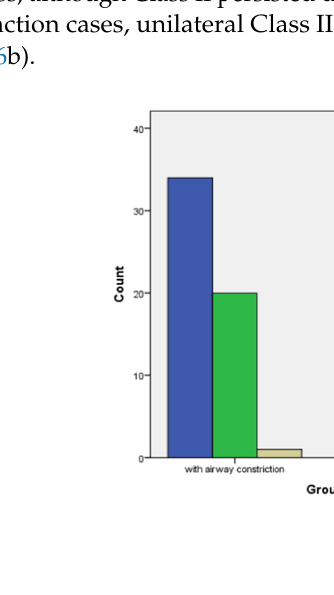
Figure 5. Sex and age distribution between groups. ( a ) The groups did not differ statistically signif- icantly in the proportion of women and men. ( b ) The groups did not differ statistically significantly in the proportion of women and men.